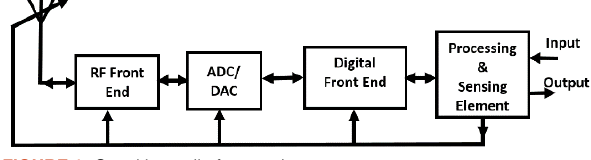
FIGURE 1. Cognitive radio front end